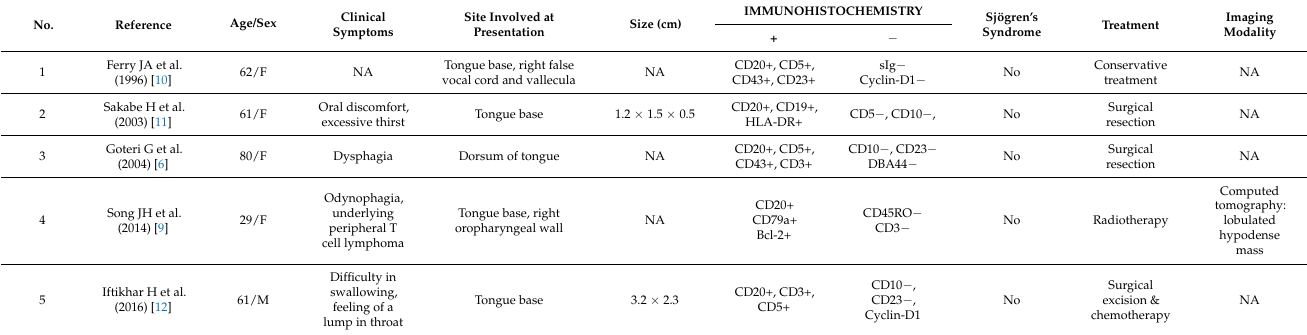
Table 1. Reported cases of MALT lymphoma of the tongue based on histopathological diagnosis in the literature †.